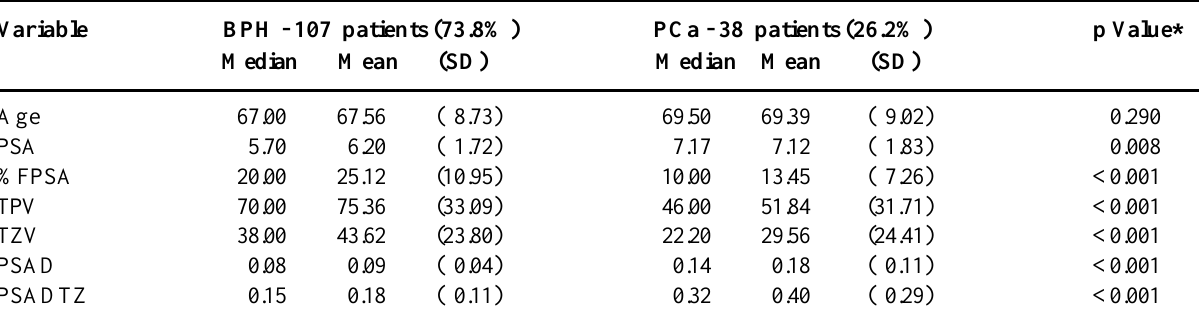
Table 2 – Median, mean and standard deviation (SD) of the age (years), serum concentration of PSA (ng/mL), %FPSA